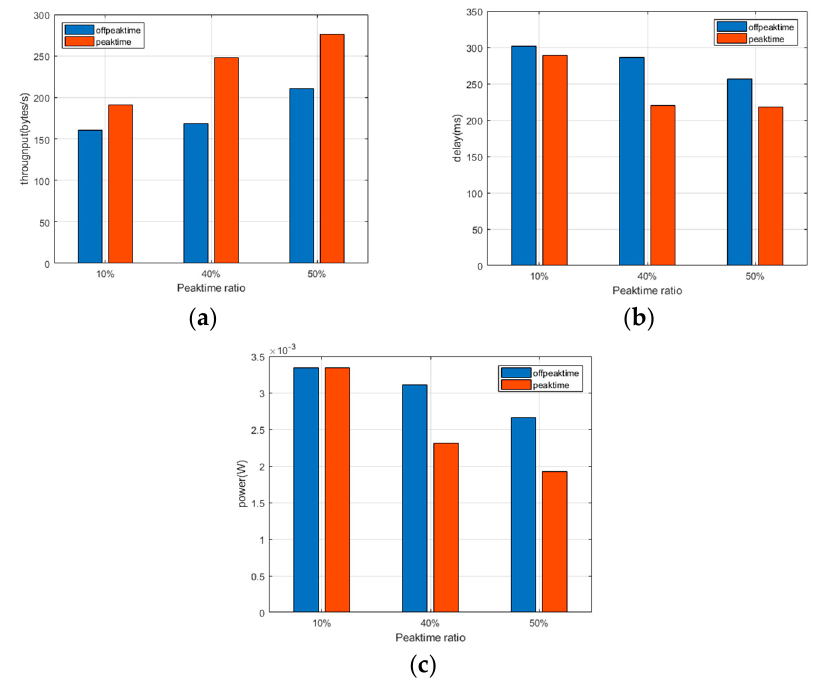
Figure 7. The comparison of the DDC-MAC performance between o ff/ peak time and peak time: ( a ) throughput; ( b ) delay; ( c ) energy consumption / s /